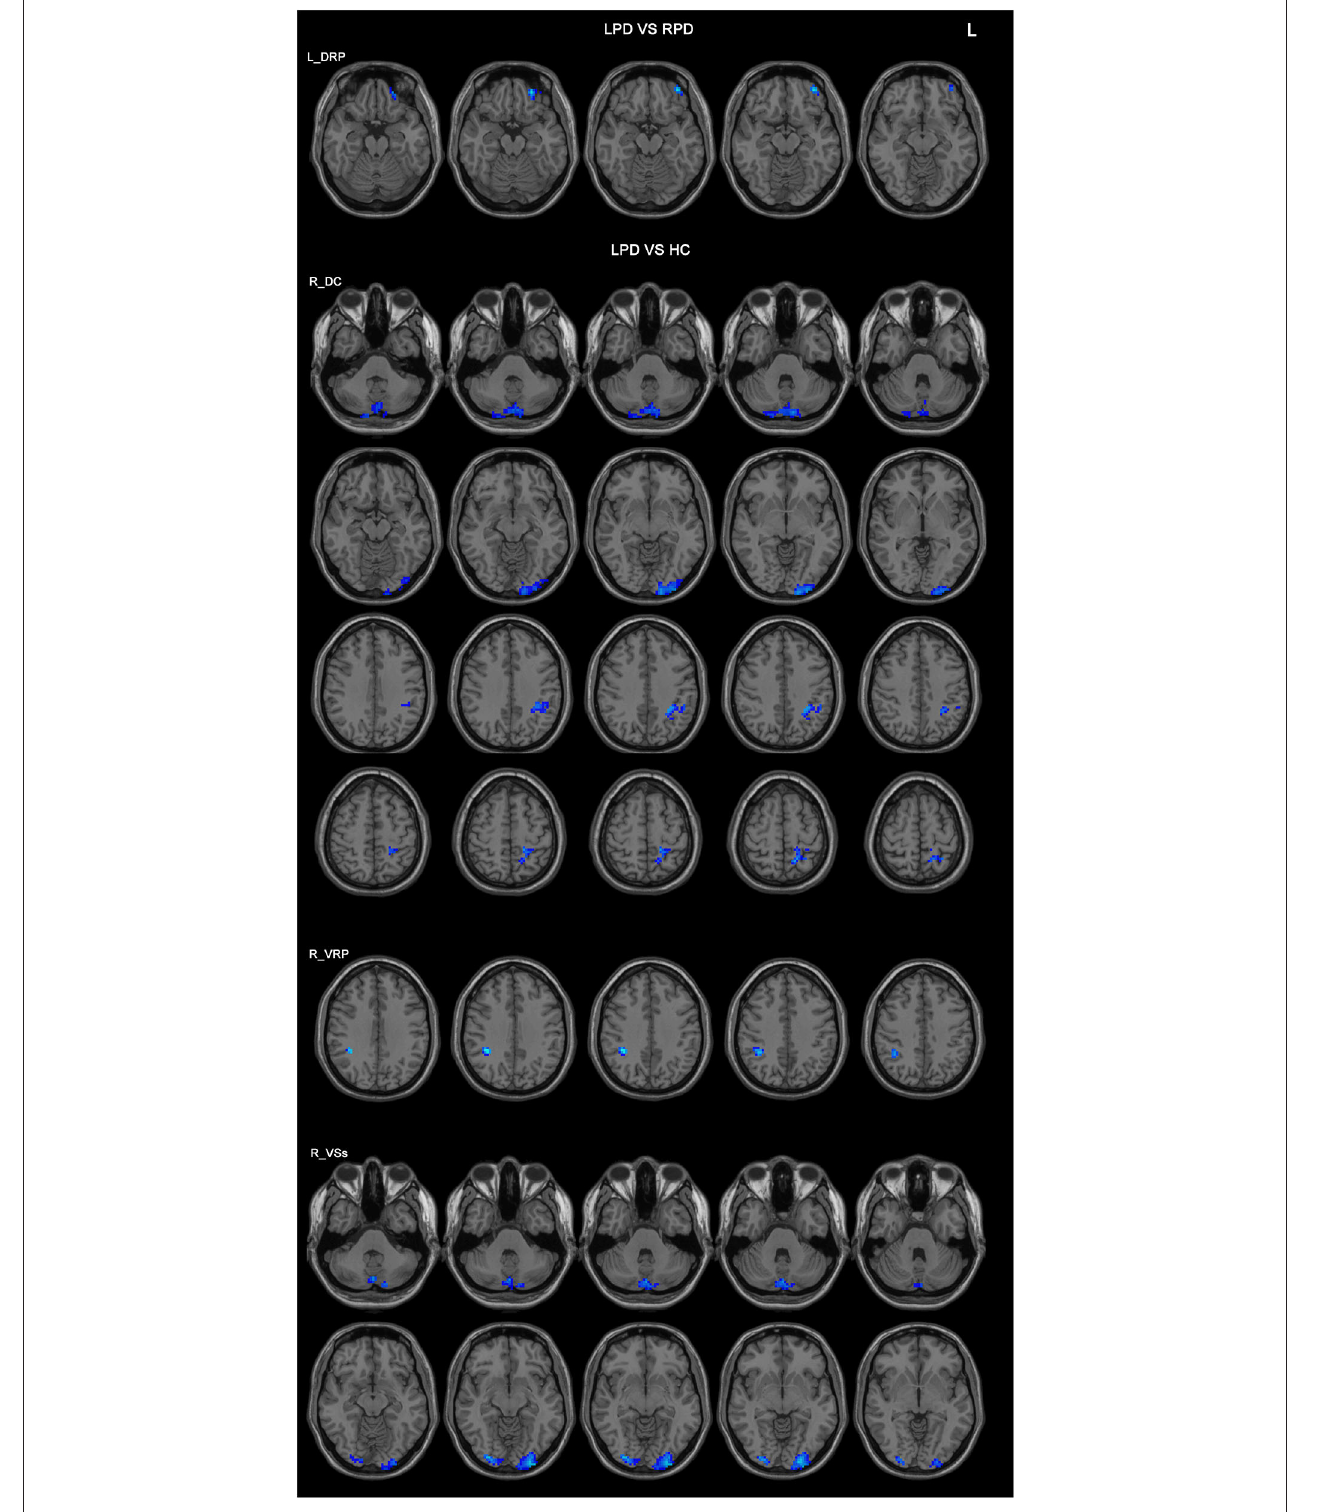
FIGURE 2 | Differences in the FC patterns between LPD and RPD patients and controls. The seed regions are indicated in the left side of the figure. LPD patients had lower FC between the left DRP and the left orbitofrontal cortex compared with RPD patients. LPD patients had lower FCs between the right DC, VRP, VSs, and various brain areas compared with controls. HC, healthy controls; DC, dorsal caudate; DRP, dorsal rostral putamen; L, left side of the brain; LPD, left-onset Parkinson’s disease; RPD, right-onset Parkinson’s disease; VRP, ventral rostral putamen; VSs, ventral striatum superior.